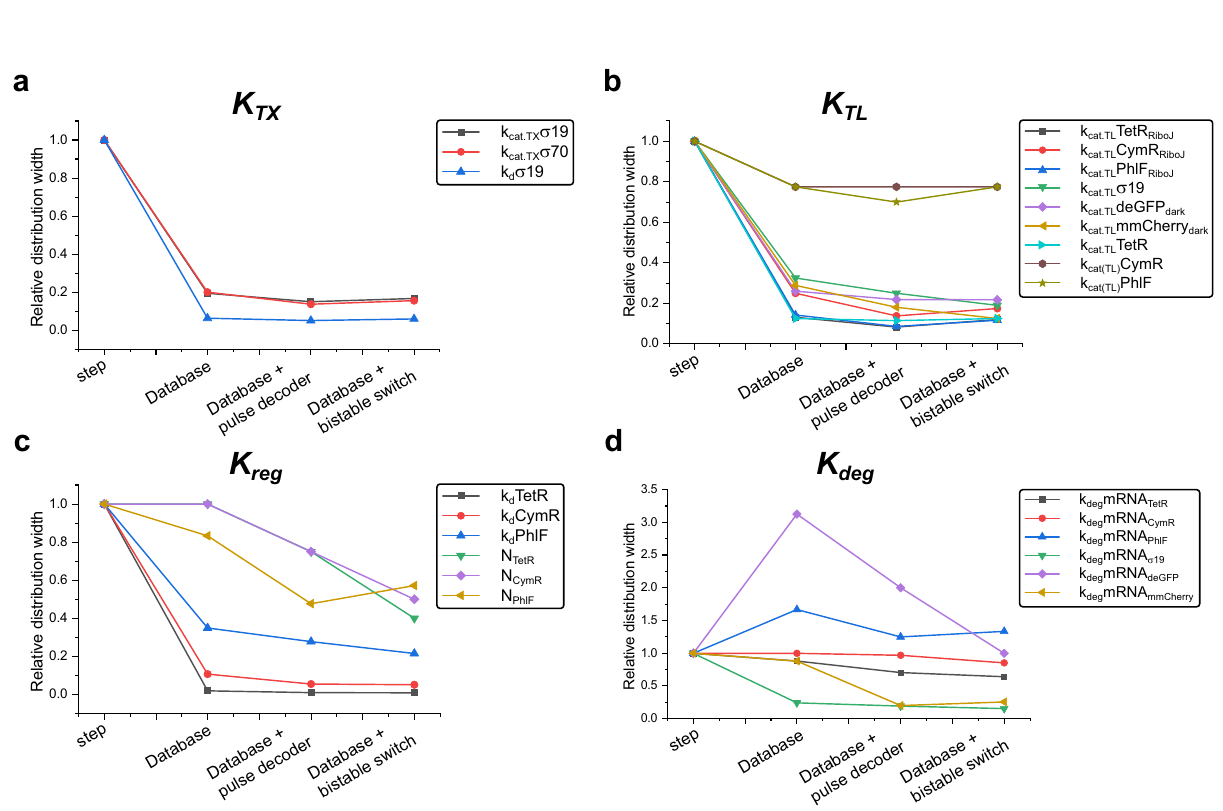
Fig. 6 Relative distribution widths. Relative distribution width, relative to the width after step calibration fi t, for all parameters grouped per category: a transcription parameters ( K TX ), b translation parameters ( K TL ), c regulation parameters ( K reg ) and d degradation parameters ( K deg